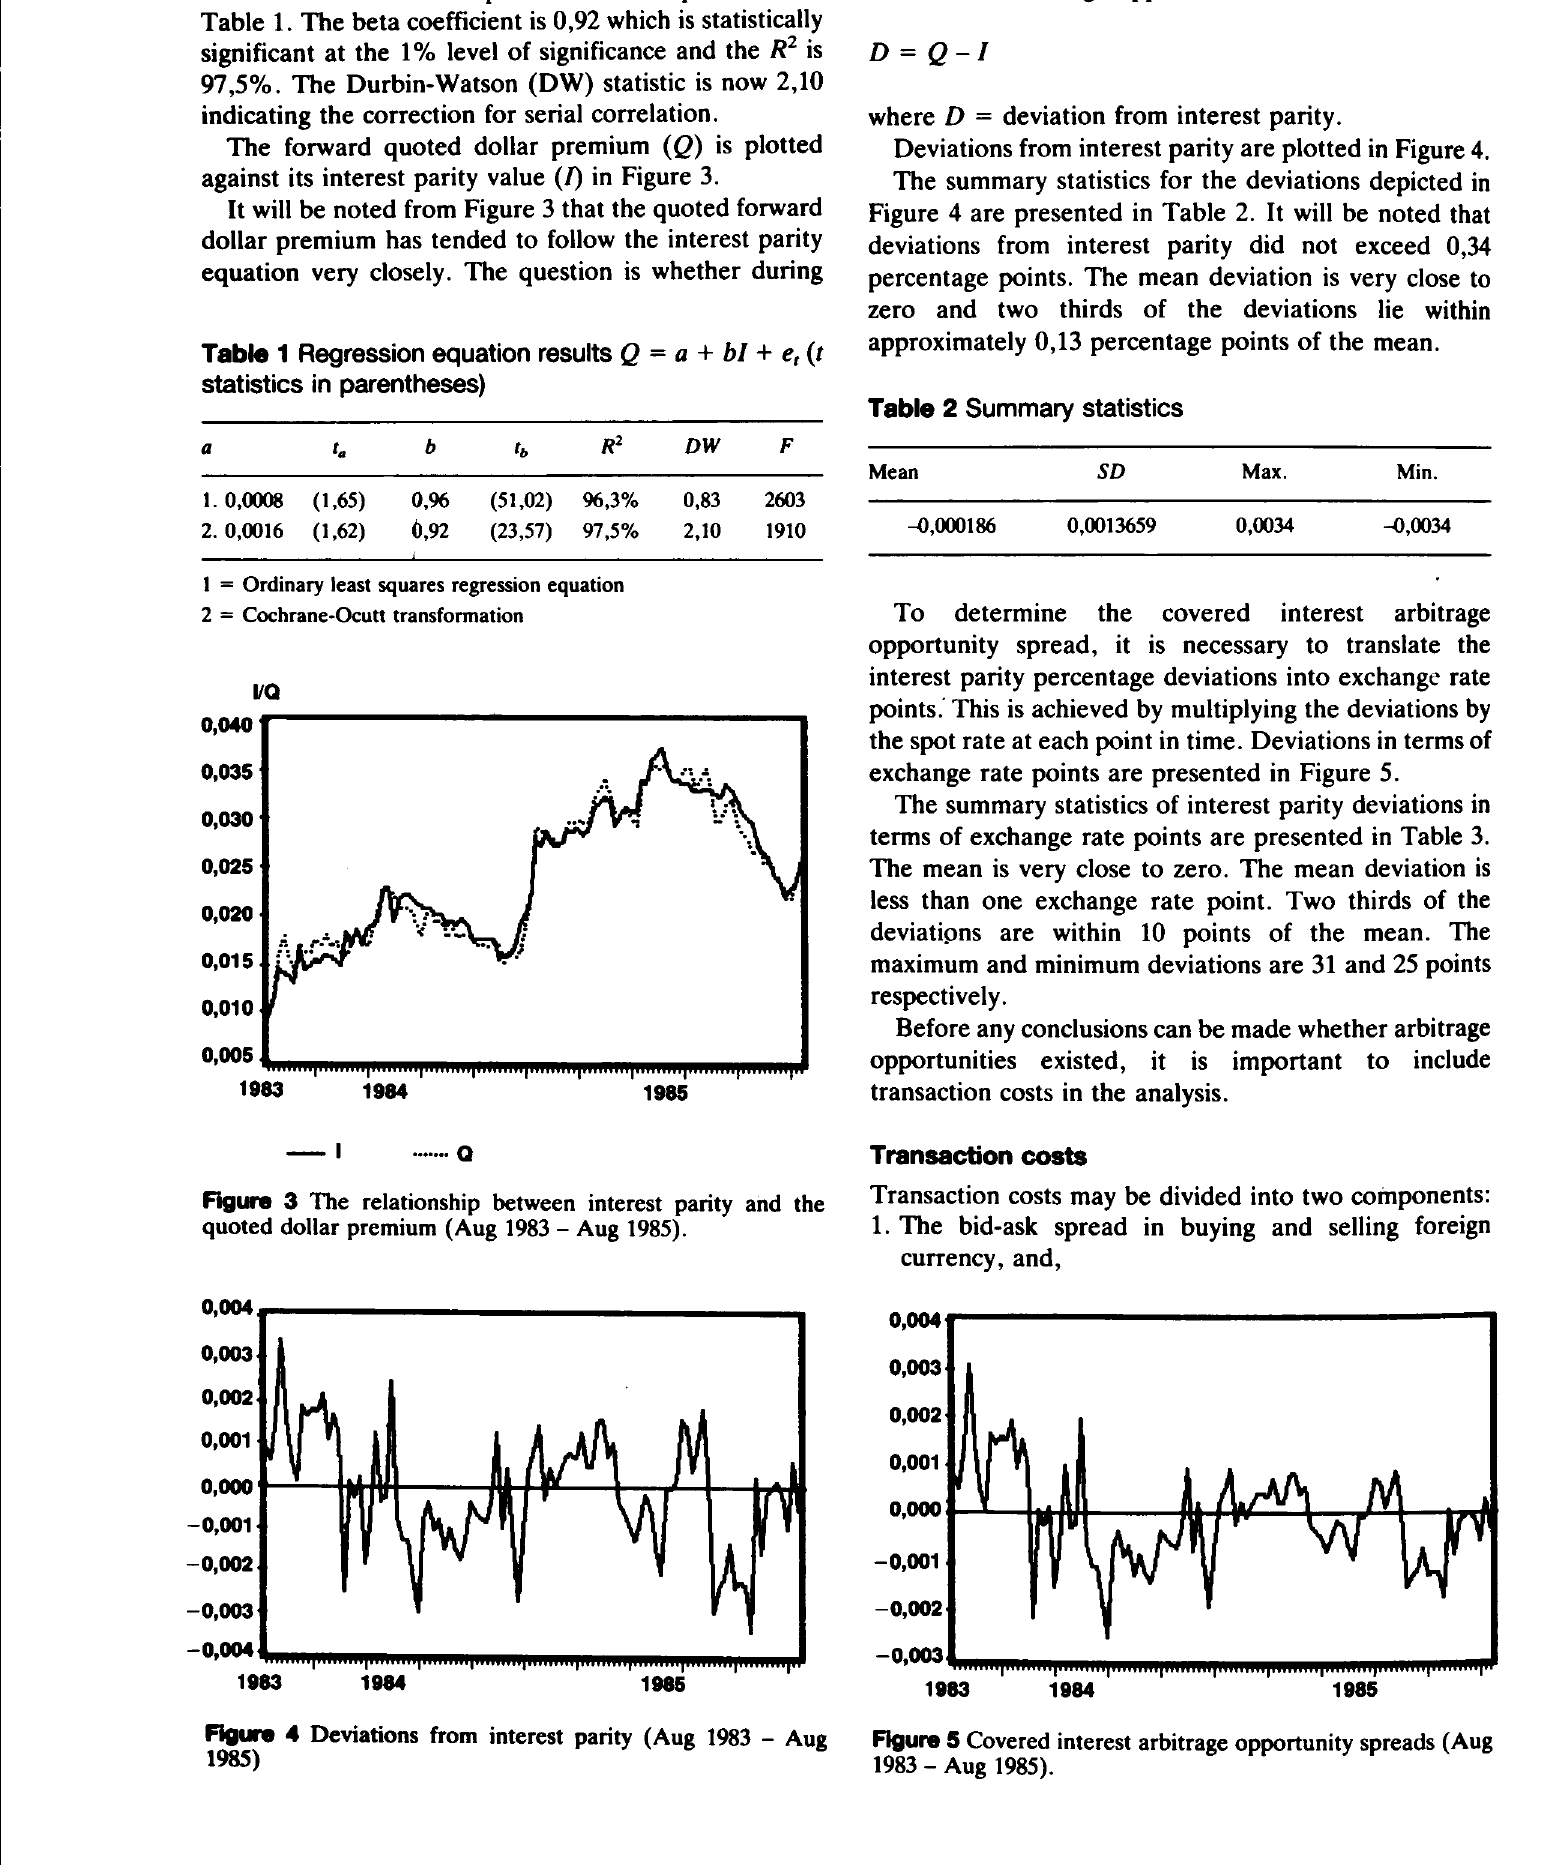
Figure 5 Covered interest arbitrage opportunity spreads (Aug 1983 - Aug